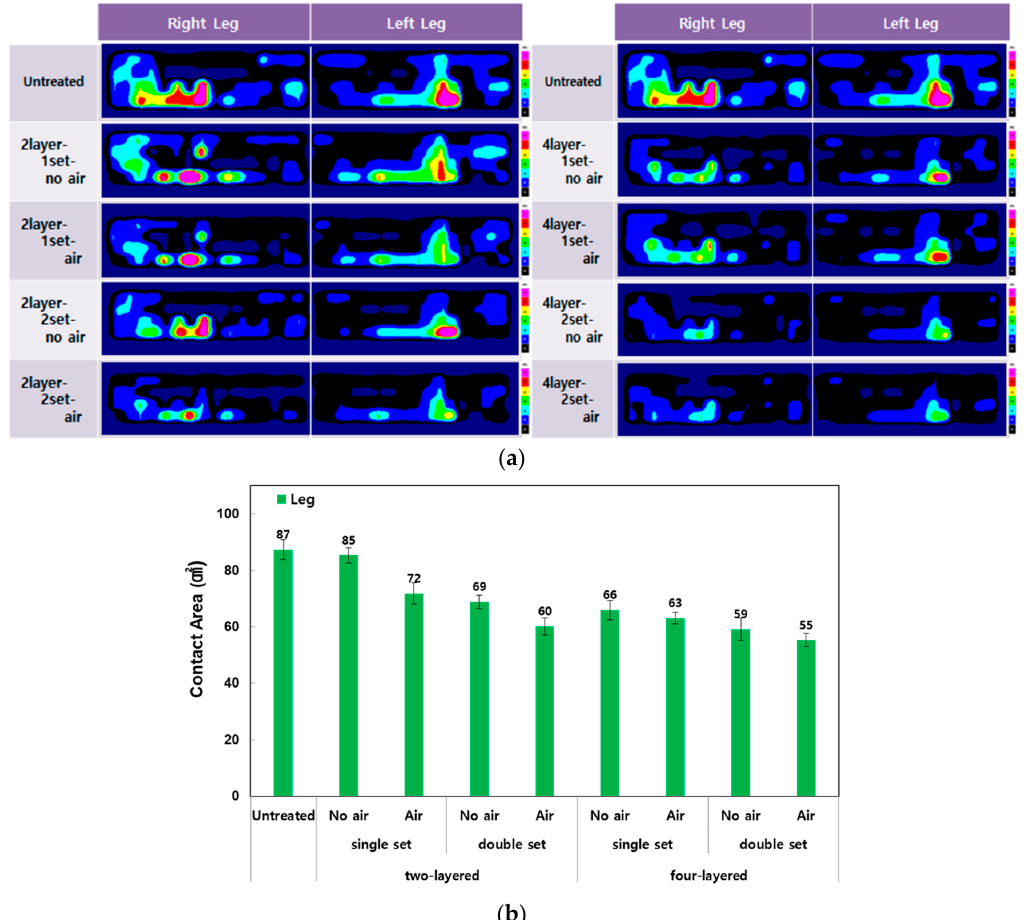
Figure 10 . Contact areas on the leg during loaded posture: ( a ) contact area distribution and ( b ) measured contact areas. Appl. Sci. 2019 , 9 , x FOR PEER REVIEW